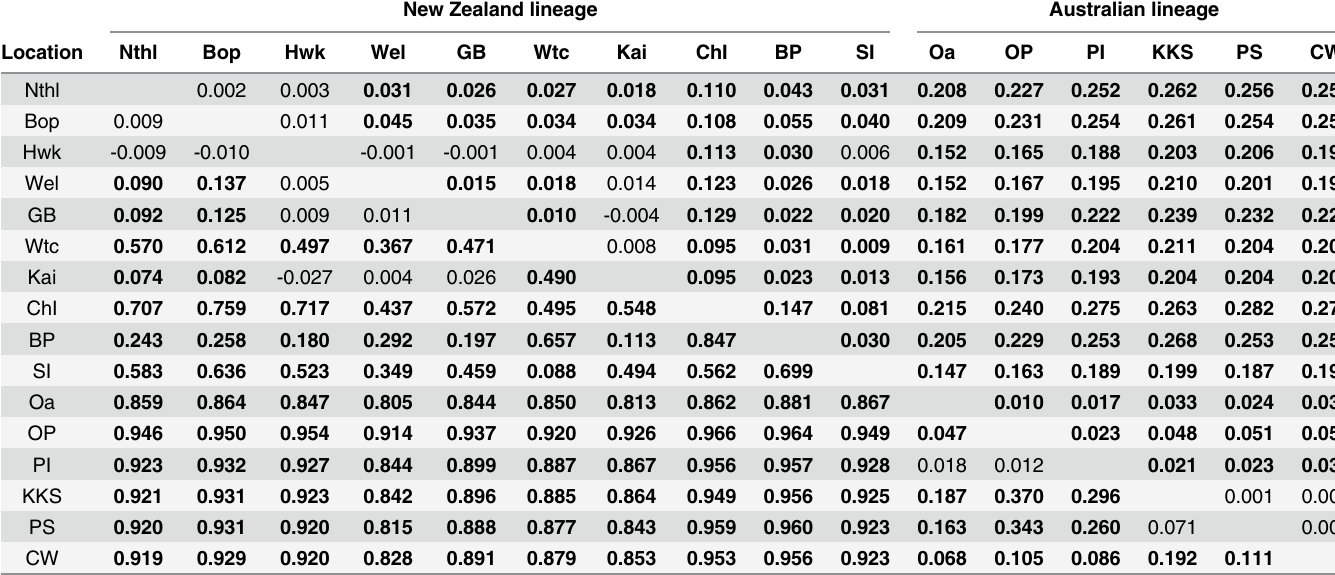
Table 2. Pairwise genetic differentiation among E . minor samples for microsatellite loci (Fst, above diagonal) and mtDNA control region ( Φ st, below